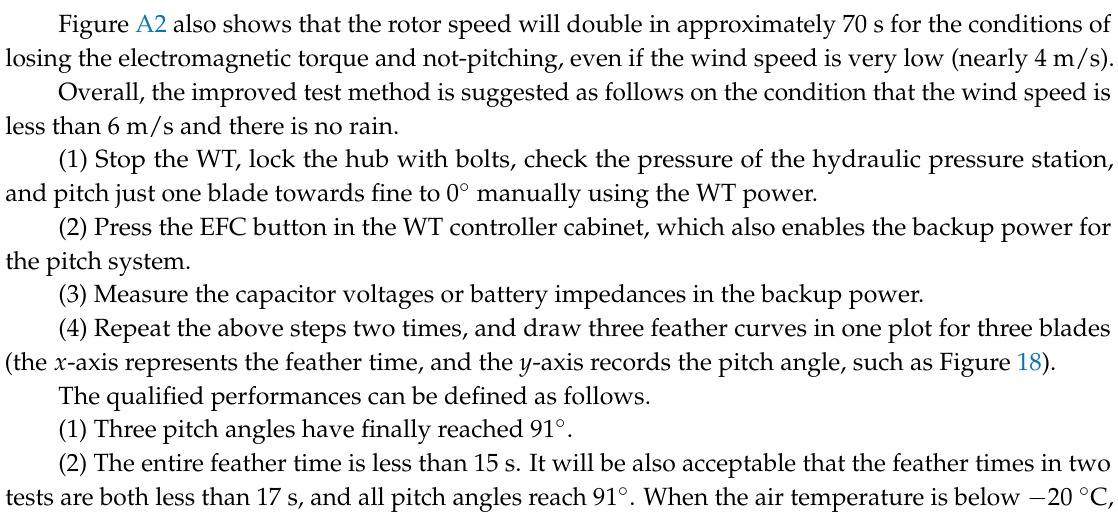
Figure A2. The operating status of the WT at the fault moment. The p.u. values of the electromagnetic torque, generator speed, rotor(hub) speed, and wind speed are 4300 N*m, 1200 rpm, 12.9 rpm, and 10 m/s,